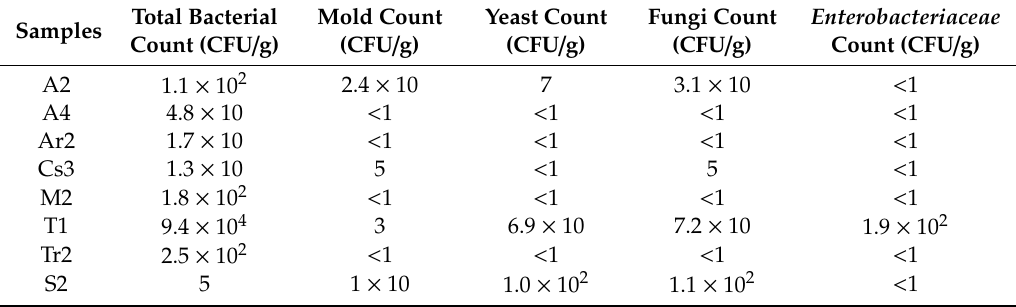
Table 1. Microbiological